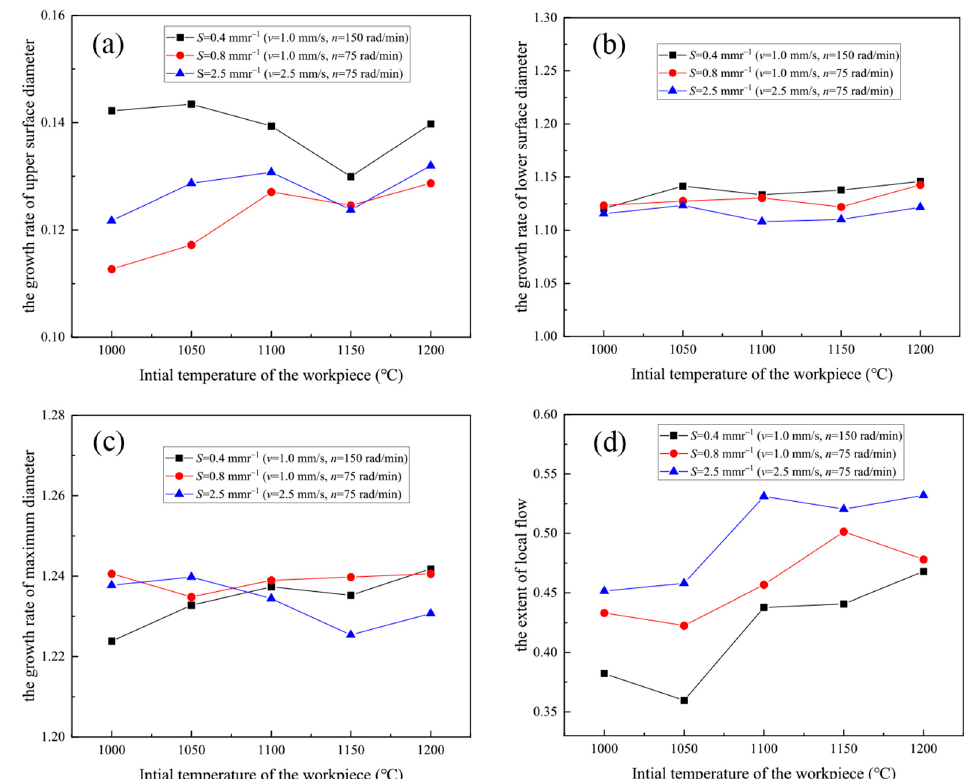
Figure 9. Influence of the feed amount per revolution S and initial temperature T of the disk workpiece on metal flow during the hot double-roll rotary forging process. ( a ) The growth rate of upper surface diameter. ( b ) The growth rate of lower surface diameter. ( c ) The growth rate of maximum diameter. ( d ) The extent of local flow at different heights L f .